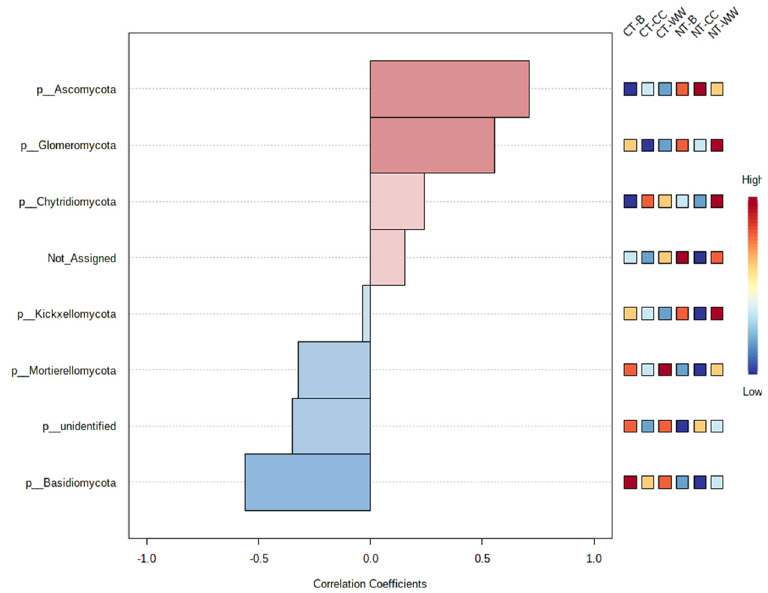
Figure 2. Pattern correlation and heat map analysis of fungal phyla across different management systems. Bars indicate the correlation coefficients of the different phyla which are ranked by correlation and to the right, heatmap showing levels of abundance (red-higher; blue-lower) in each system. (CT-B: Conventional Tillage-Bare fallow; CT-CC: Conventional Tillage-Cover Crop; CT-WW: Conventional Tillage-Winter Weeds; NT-B: No-tillage- Bare fallow; NT-CC: No-tillage-Cover Crop; NT-WW: No-tillage-Winter Weeds). Table 3. Effect of tillage and winter cover management systems on soil physiochemical